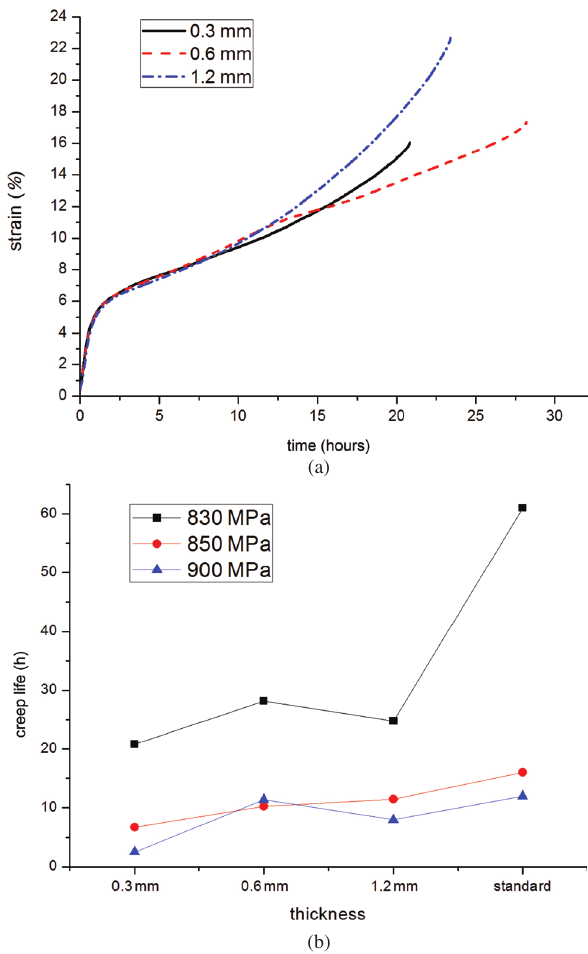
Figure 2: (a) Creep strain vs. time, curves for sheet specimens with δ = 0.3 mm, 0.6 mm and 1.2 mm tested at 760 ℃ /830 MPa. (b) Effect of specimen thickness on the average rupture life at 760 ℃ /830 MPa, 850 MPa and 900